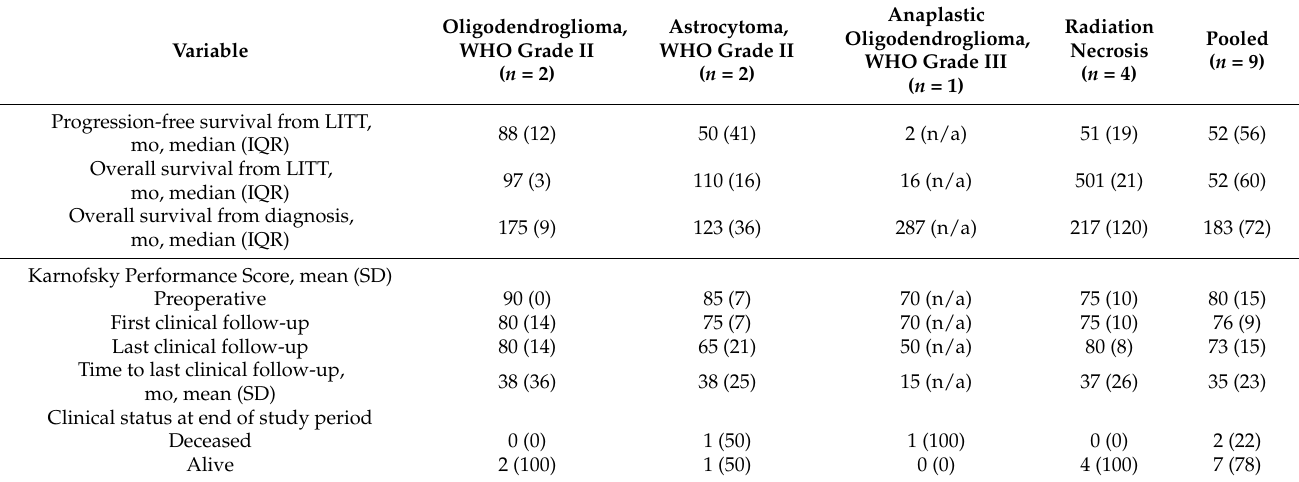
Table 4. Survival analysis and clinical outcomes of 9 patients with low-grade glioma (LGG) and radiation necrosis (RN) treated with laser interstitial thermal therapy (LITT).